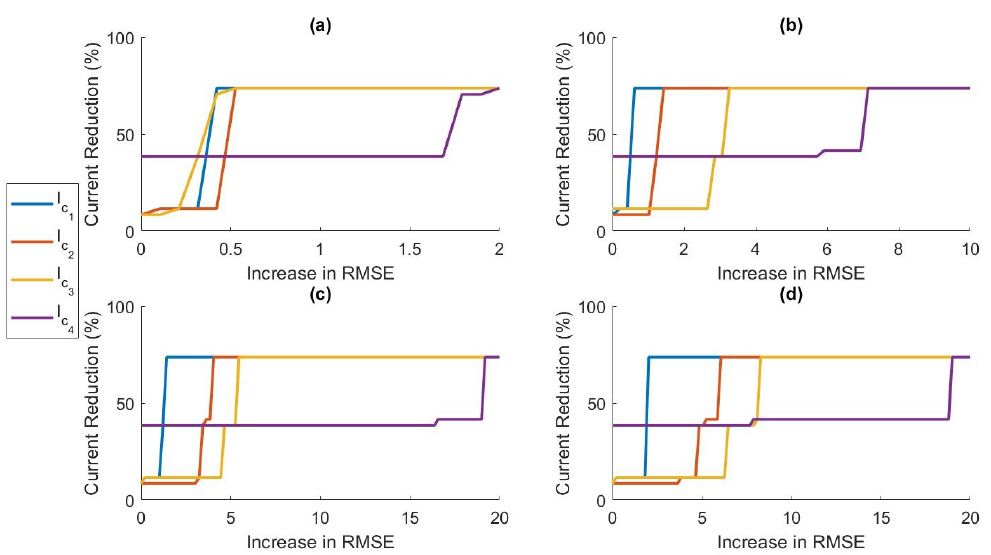
Figure 8. The effect of increasing allowable prediction RMSE on the current consumption for: ( a ) δ h = 10; ( b ) δ h = 30; ( c ) δ h = 60; and ( d ) δ h = 90, for each